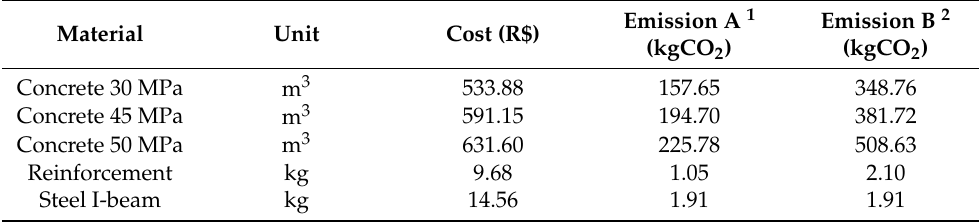
Table 2. Unit costs and emissions of each